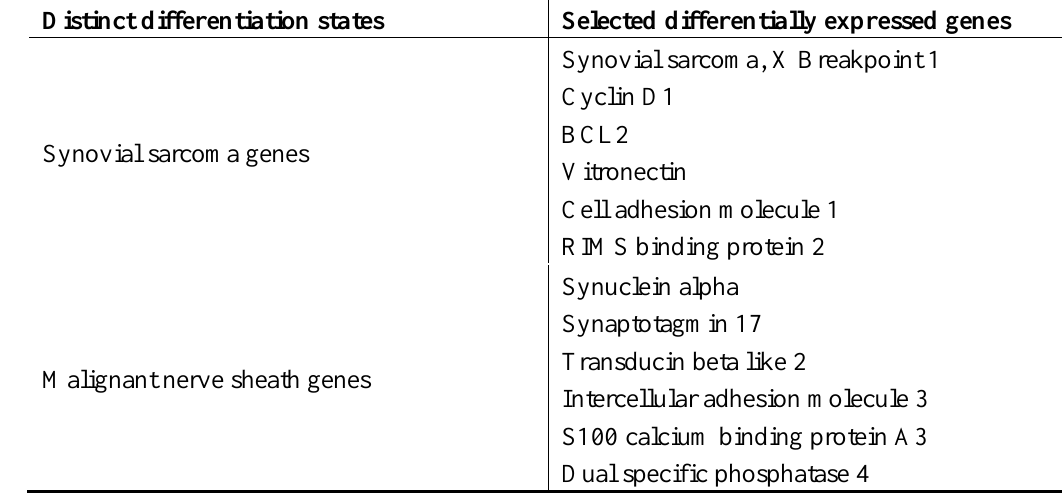
Table 4. Distinct expression pattern in the second step of the Hardvard Study, a 35 gene